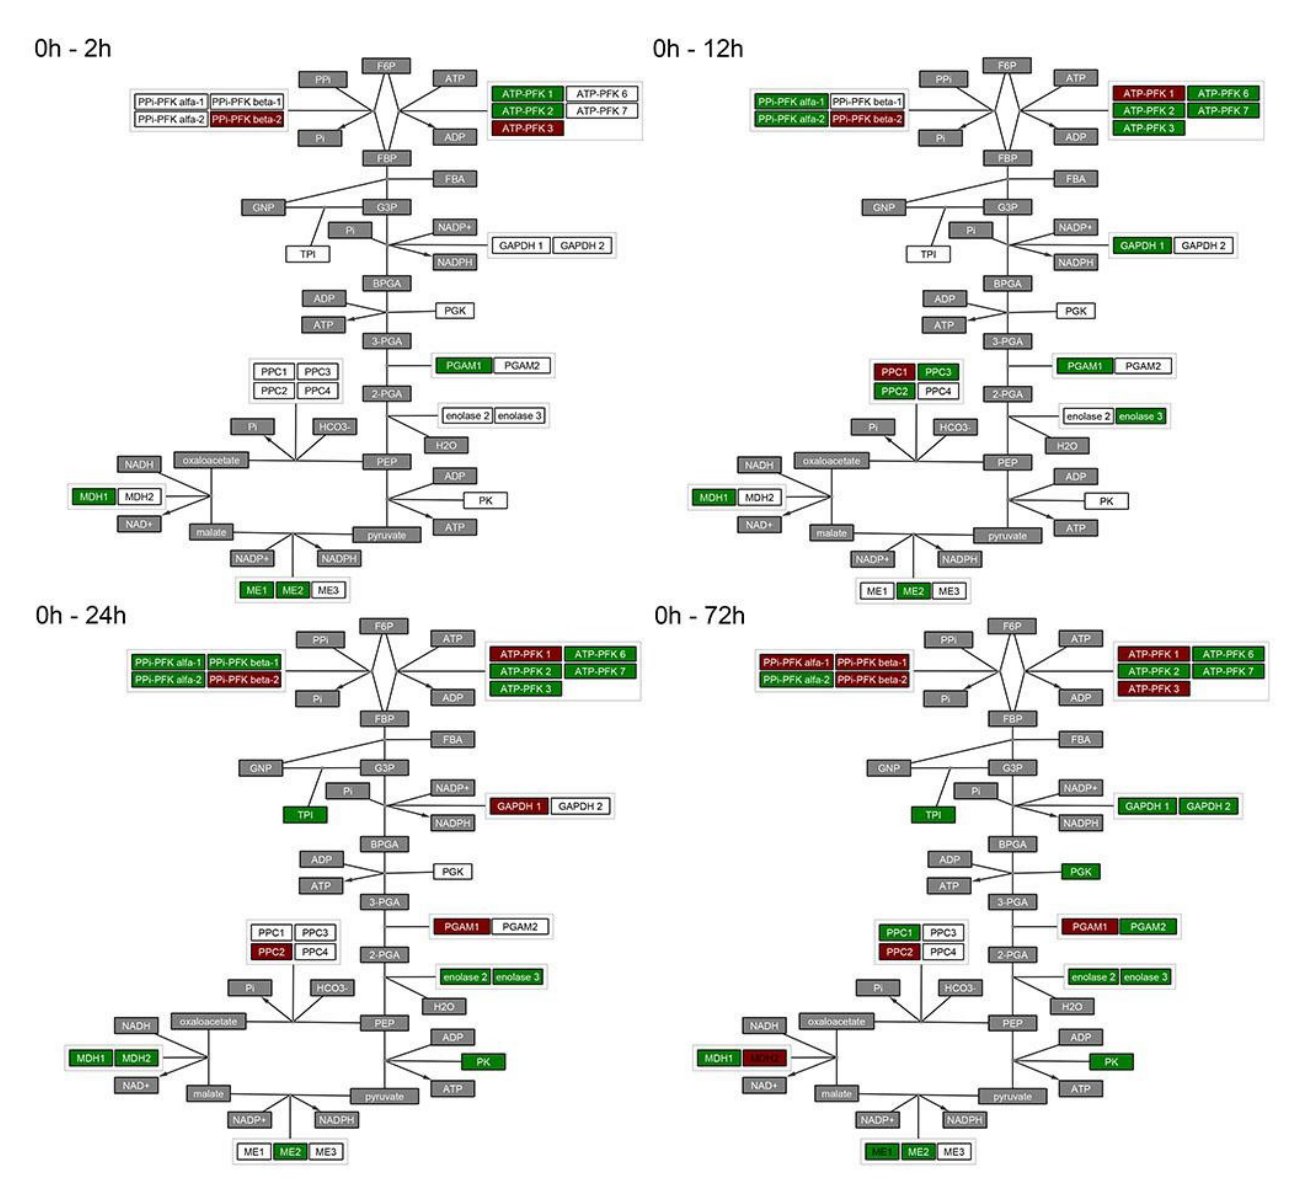
Figure 3. Small multiples showing temporal changes in the expression of genes acting in the glycolysis/TCA cycle induced in germinated A. thaliana seeds by incubation in ABA for 0, 2, 12, 24 and 72 h. A general activation of the cycle can be observed and may be a mechanism by which the plant cell prepares for the energy demands of recovery from drought. Red nodes indicate genes with significantly declining transcript abundance. Green nodes indicate genes with significantly accumulating transcripts. White nodes indicate genes without significant changes in transcript abundance. Grey nodes indicate components that are not genes or do not have data